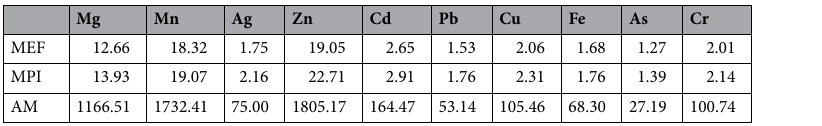
Table 9. Pollution